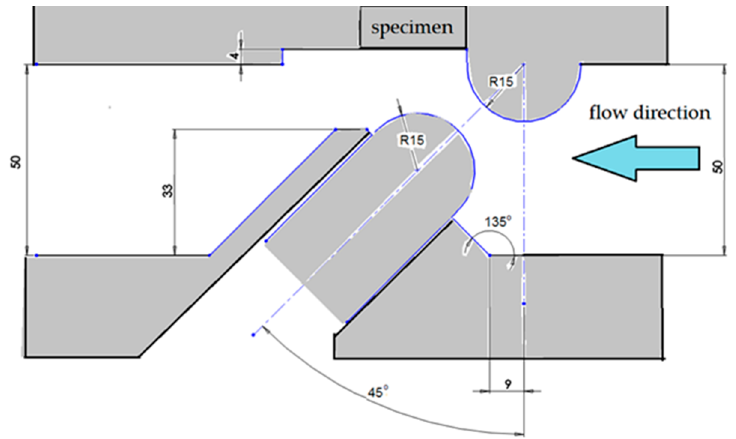
Figure 2. Cavitation chamber with a system of barricades, reprinted from Coatings , Reference [25], published in MDPI.